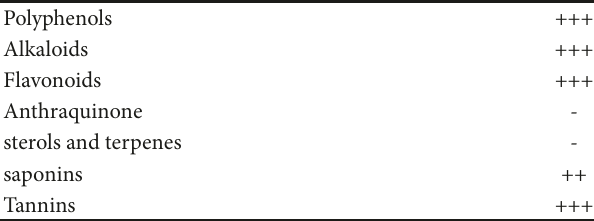
Table 1: Phytochemical screening of A. baetica roots. Polyphenols +++ Alkaloids +++ Flavonoids +++ Anthraquinone - sterols and terpenes - saponins ++ Tannins